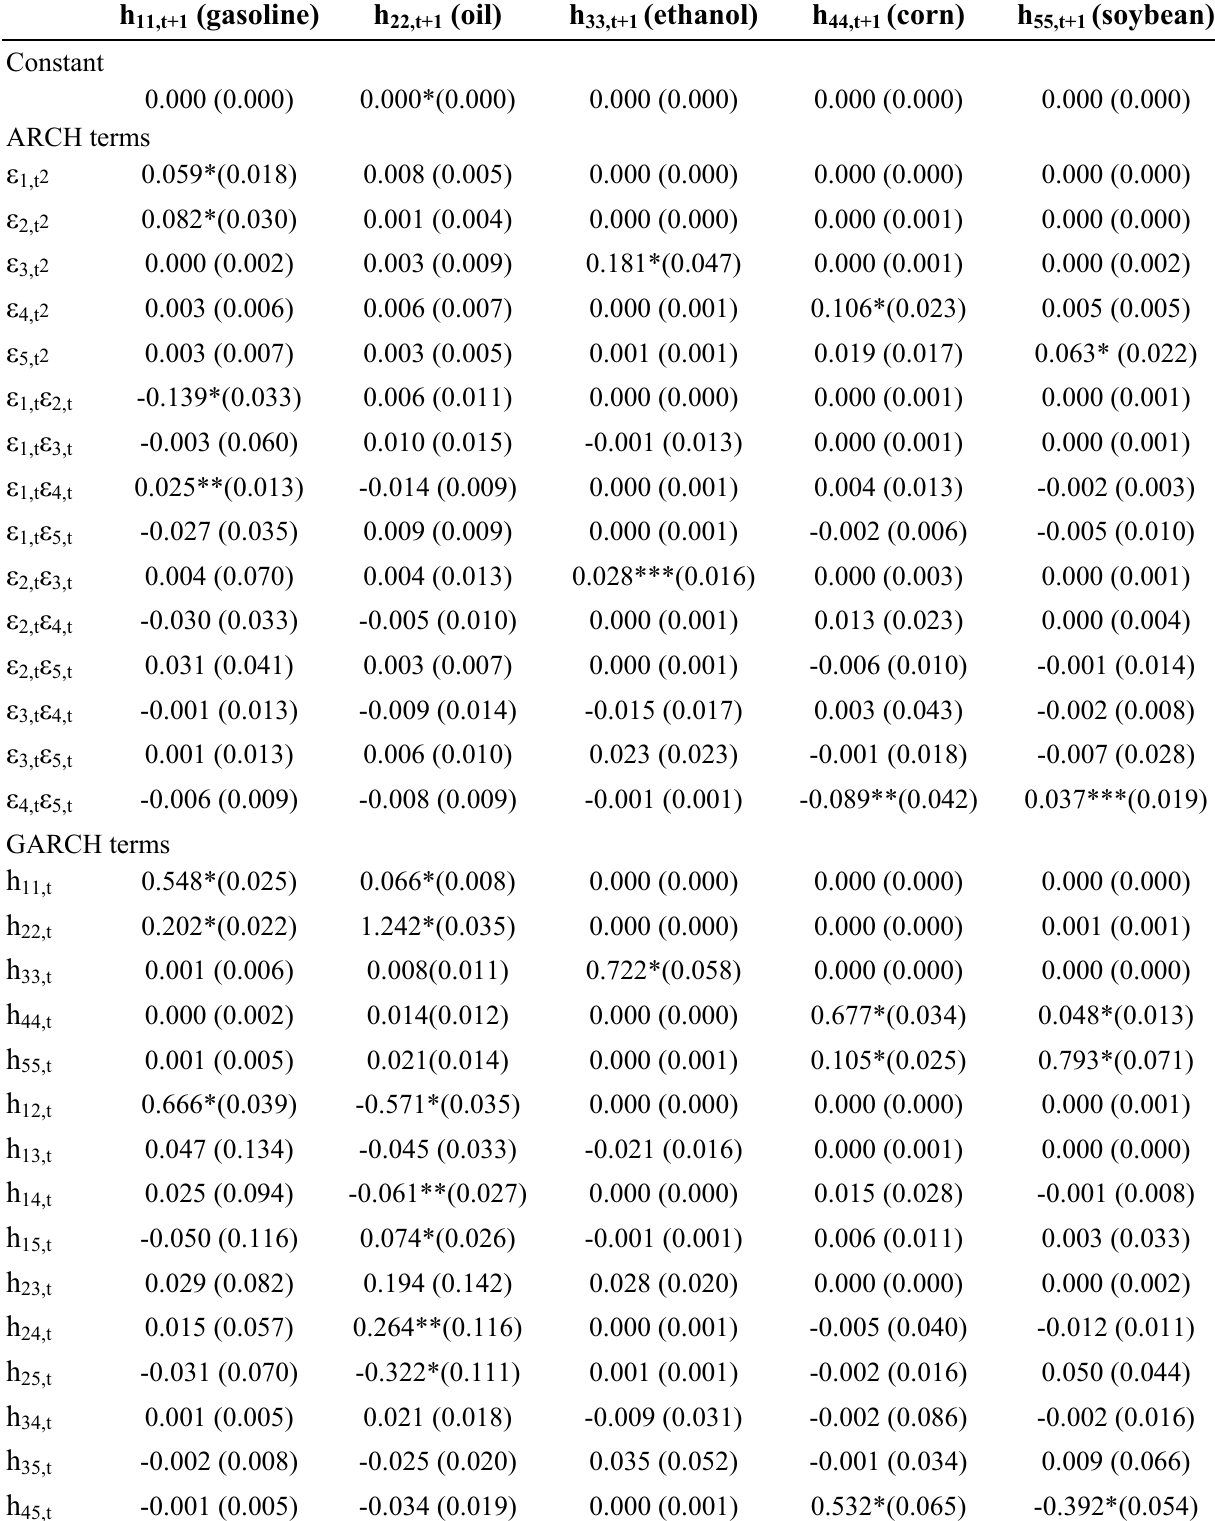
Table A5. MGARCH(1,1) Results for the Pre-Ethanol Boom